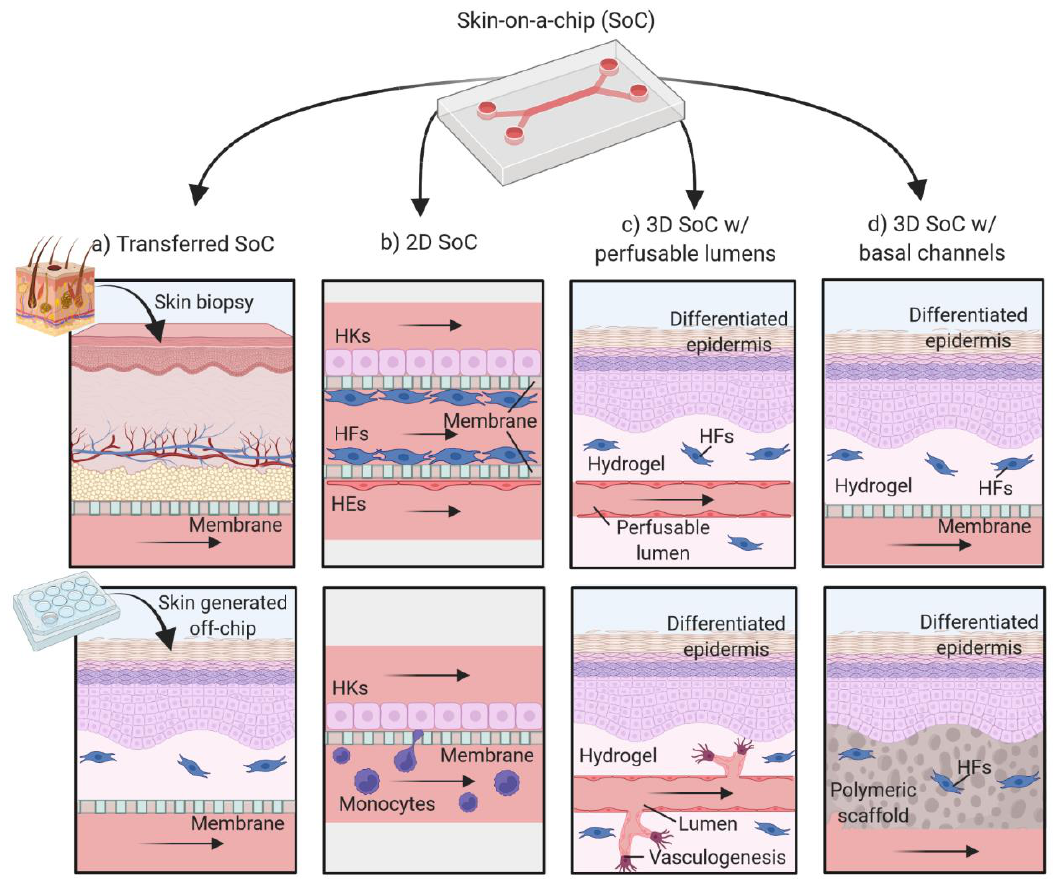
Figure 8. Schematic diagram of the strategies used to develop SoC models. ( a ) Transferred SoC devices in which skin biopsies ( top ) or skin models generated off-chip ( bottom ) are transferred on-chip. ( b ) 2D SoC devices in which cell monolayers are cultured on porous membranes, establishing different compartments. Two-dimensional SoC with 2 membranes (3 compartments) ( top ) and 1 membrane (2 compartments) ( bottom ) ( c ) 3D SoC with perfusable lumens ( top ). The perfusable lumens are created using 3D patterning techniques, typically using templating, sacrificial modeling or bioprinting. This approach can be combined with vasculogenesis ( bottom ). ( d ) 3D SoC with microfluidic channels. Membrane-based SoC device in which the microfluidic layers and a porous membrane are assembled in a sandwiched stricture ( top ). The skin model is cultured in situ on top of the membrane. Alternatively, a porous scaffold can be integrated, excluding the use of the membrane and hydrogel. Abbreviations: HKs, human keratinocytes; HFs, human fibroblasts, HEs, human endothelial cells. The most common application of SoC devices has been the maintenance of skin tissues under dynamic perfusion to increase their longevity and/or to establish a co- culture of tissues modeling different organs (Figure 8a). The skin tissues integrated on the chips are typically skin biopsies [103 – 105] or FTSm developed off-chip [102,106 – 108]. These studies provide valuable information regarding the use of SoC devices and their